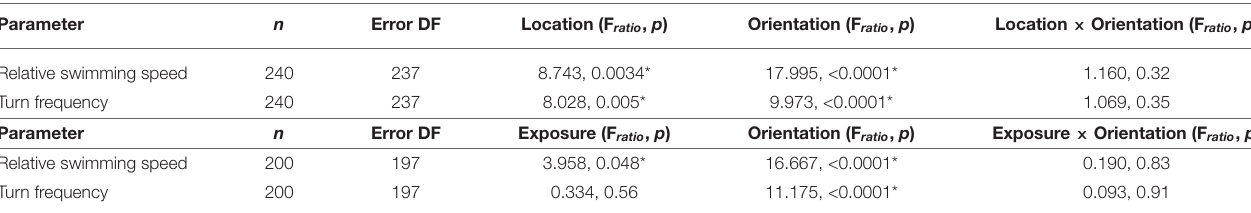
Parameter n Error DF Location (F ratio , p ) Orientation (F ratio , p ) Location × Orientation (F ratio , p ) Relative swimming speed 240 Turn frequency Parameter n Error DF Exposure (F ratio , p ) Relative swimming speed 200 Turn